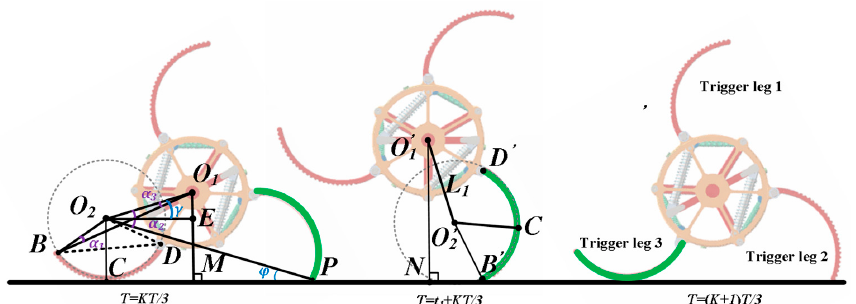
Figure 7. Wheel change process in one cycle.